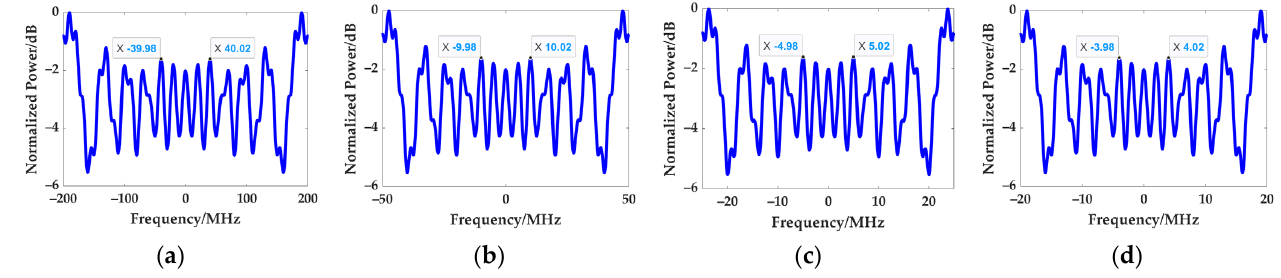
Figure 10. Spectrum of LFM pulse with the fixed time-bandwidth product of 50 and varying pulse width of: ( a ) 0.1 μ s; ( b ) 0.4 μ s; ( c ) 0.8 μ s; ( d ) 1 μ s.